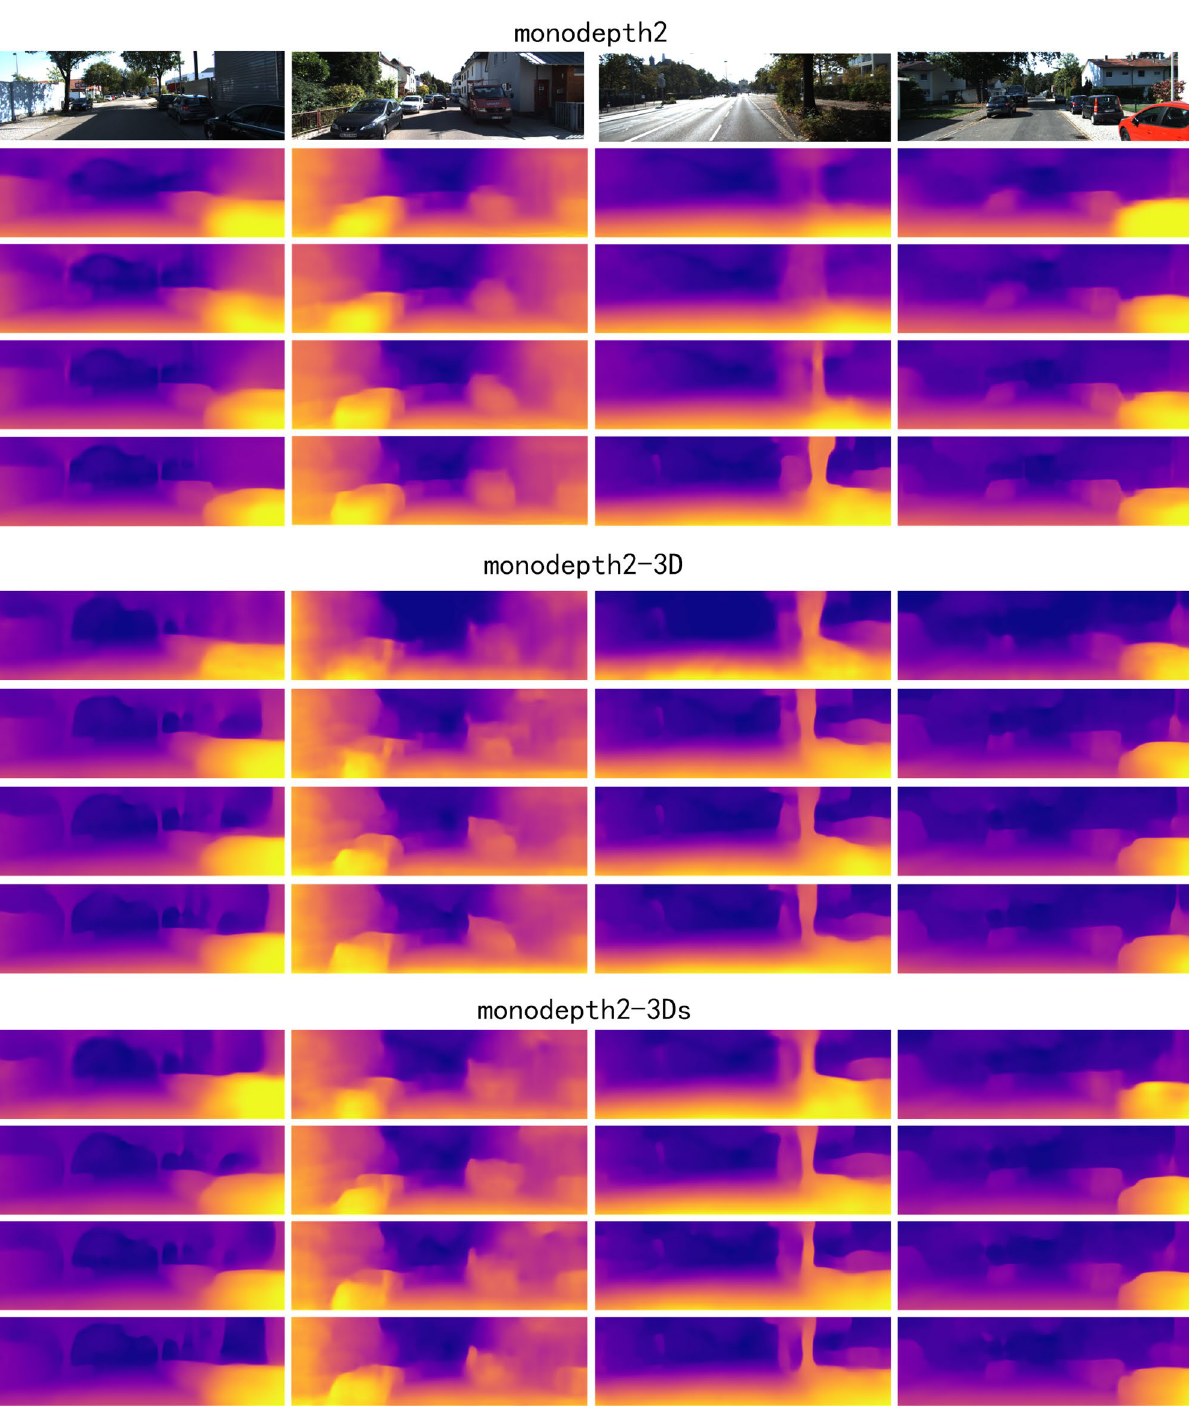
Figure 7. Qualitative results of different models in KITTI.In these models, we used different pre-training weights and a completely consistent tuning process. The results for each model are, from top to bottom, train from scratch, ImageNet, MNv1.2 and